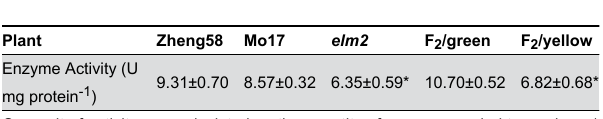
Table 3. HO activity assay.